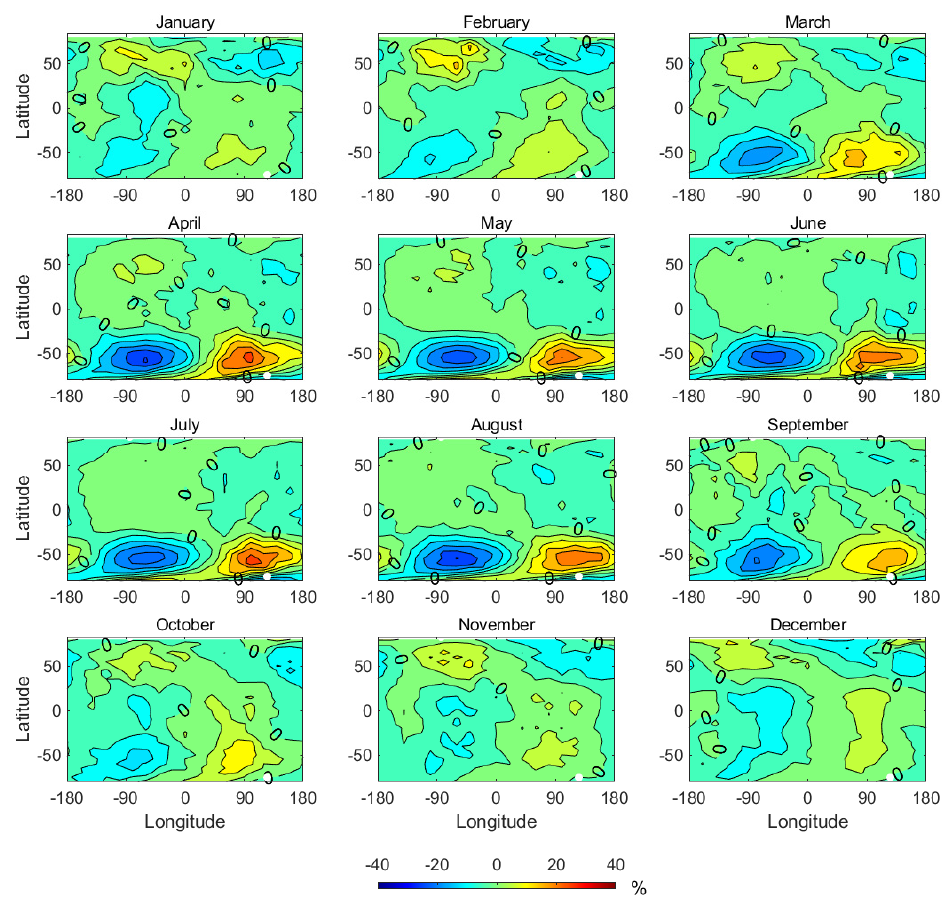
Figure 2. The global distributions of the relative longitudinal variation ( Δ ρ r ) from APOD at 0730 LT (dawn) in each month. White dots denote the position of the south geomagnetic pole.